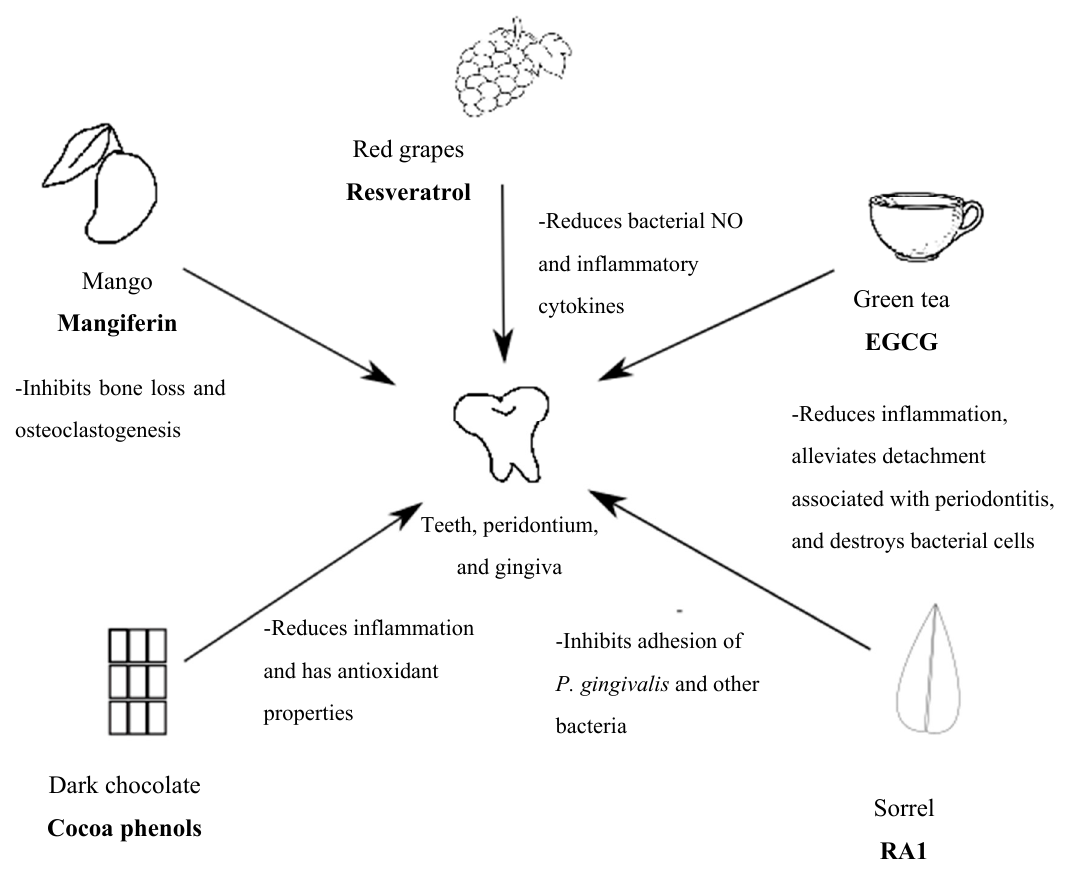
Figure 1. Overview of the role of dietary polyphenols in the management of periodontitis.